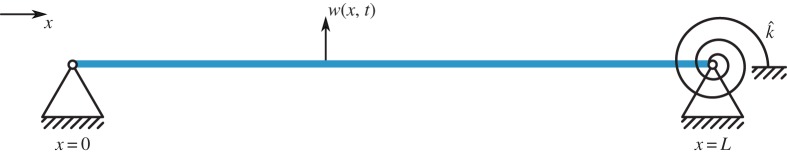
Schematic of a pinned-pinned beam with a rotational constraint at one end. (Online version in colour.)